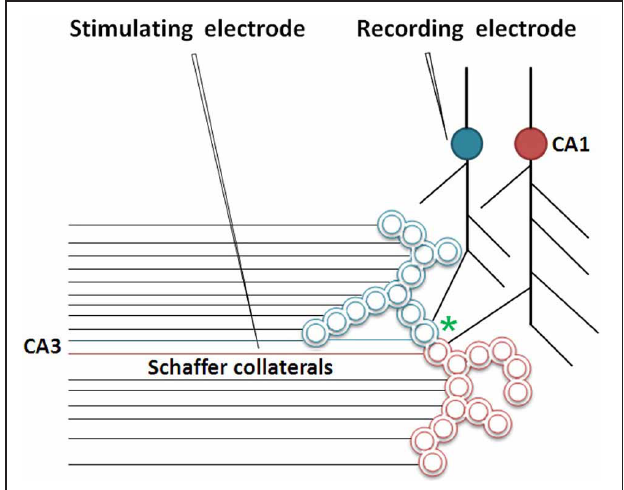
FIGURE 5 | Cartoon showing the role of inter-postsynaptic membrane hemi-fusion in LTP. The stimulation of a large number of Shaffer collateral fibers during LTP induction results in hemi-fusion between two postsynapses that belong to two large islets of functionally LINKed postsynapses (in green and red; Note that the double-walled circles are cross sections through the postsynapses as demonstrated in Figure 2 ). The critical location of hemi-fusion is shown by an asterisk. This results in the merger of these islets to form mega-islets. Following the LTP induction, a regular stimulus at the stimulating electrode induces EPSPs at the postsynapses belonging to both the islets. The recording electrode that records potentials arriving through the blue-colored islet of LINKed postsynapses will start recording the cumulative EPSPs arriving from both the red and blue colored postsynapses of the newly formed mega-islet [Modified from Vadakkan